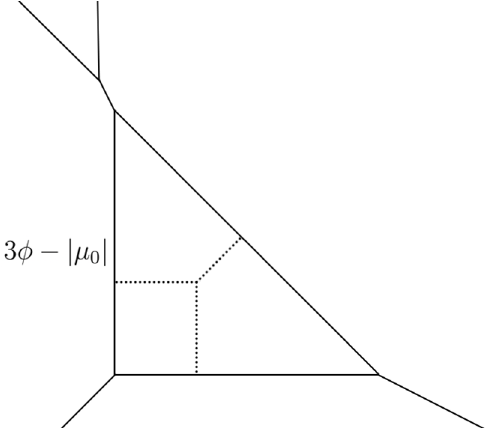
Figure 19 . The flopped F1 brane web and the junction string. Notice that the mass of the junction string also equals the length of the